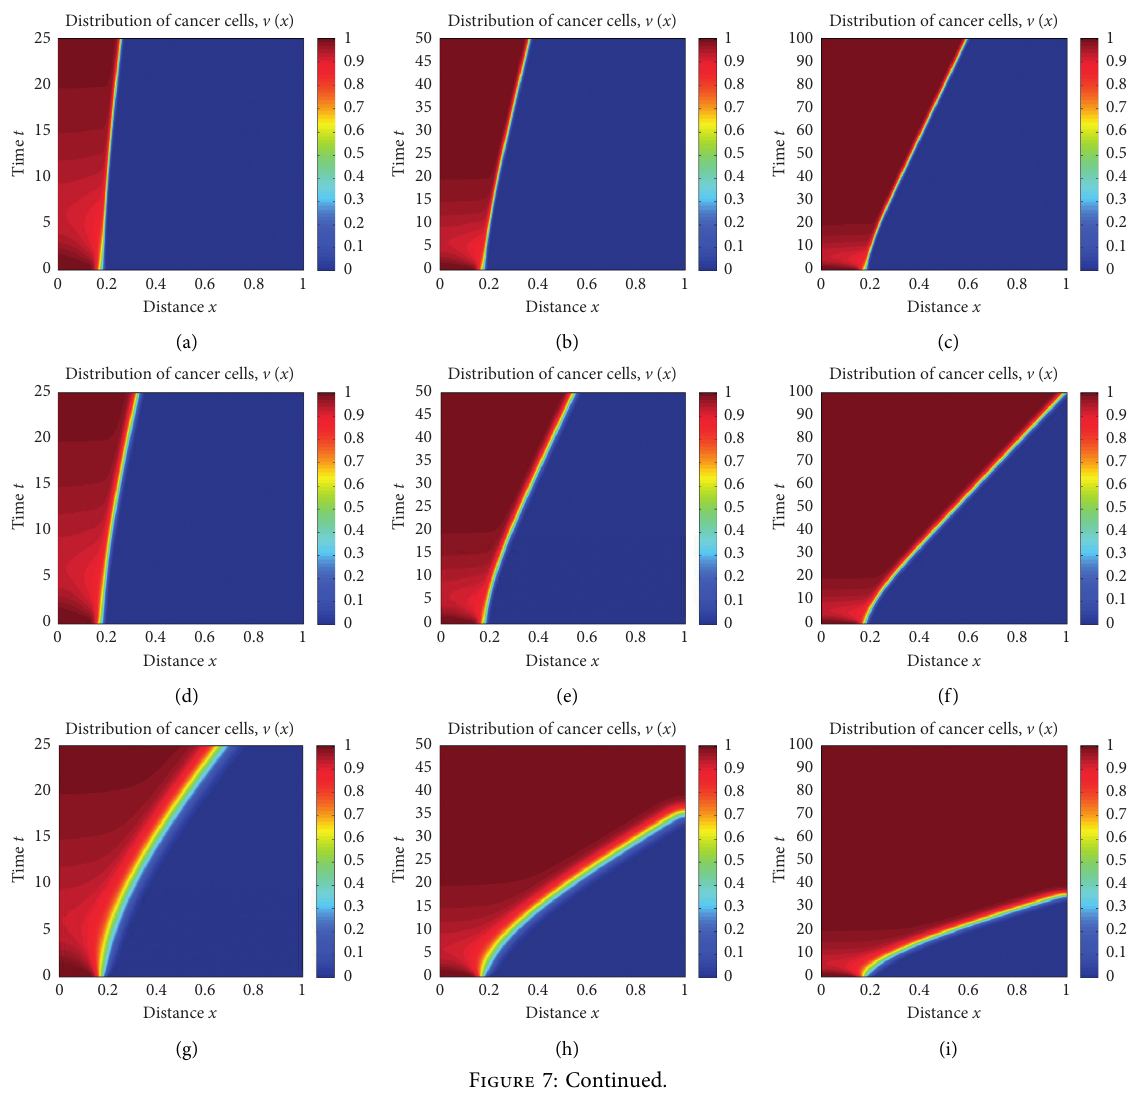
� 0 . 0000048, the second row is for d 2